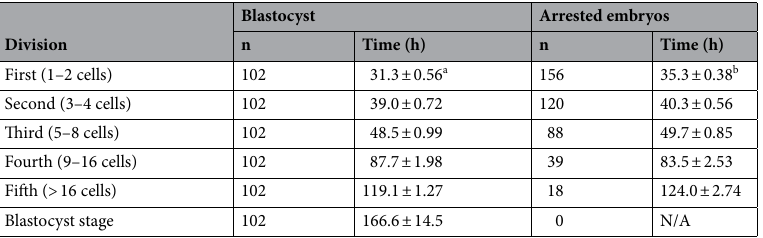
Table 1. Comparison of the time to reach each division between zygotes that reached the blastocyst stage and arrested embryos. n = number of zygotes/embryos analyzed. Different superscripts (a and b) per row represent